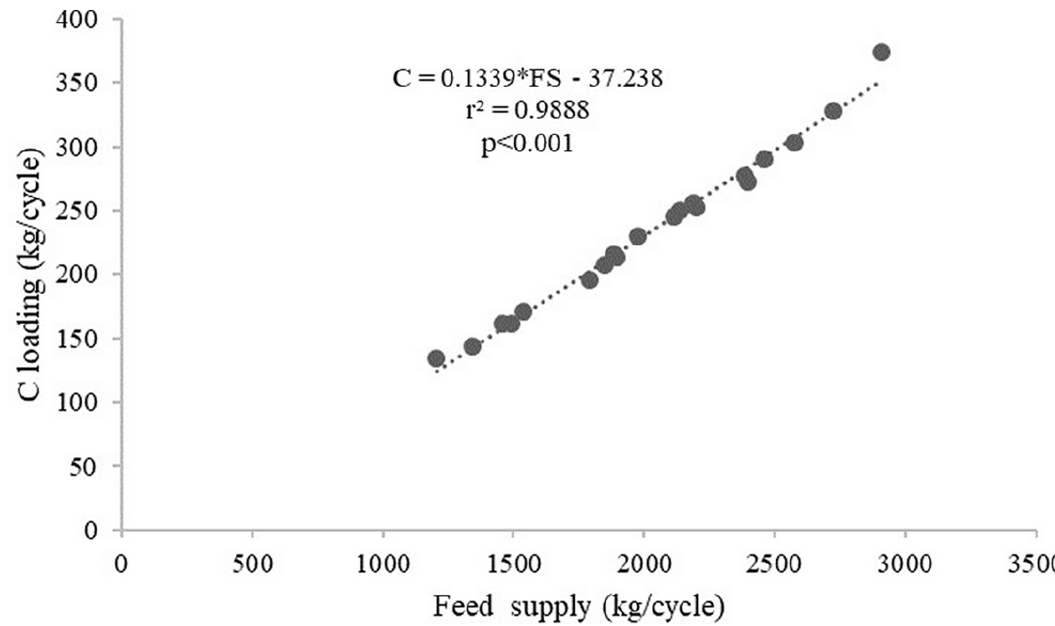
Figure 2. Feed supply and carbon loading relationship for giant gourami reared in floating